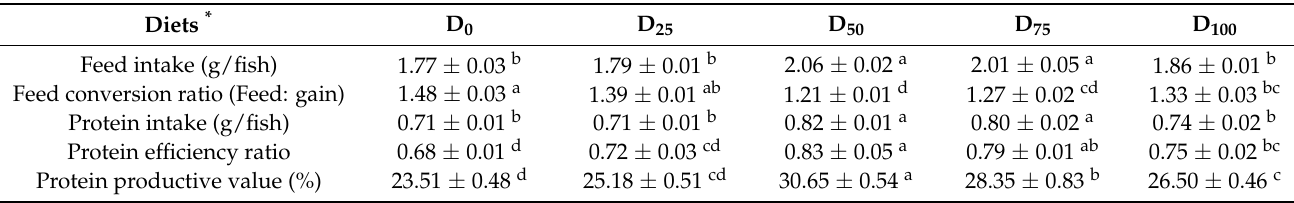
Table 5. Effect of partial or total replacement of fishmeal by amphipod meal, Gammarus pulex , on feed utilization of Mugil cephalus .